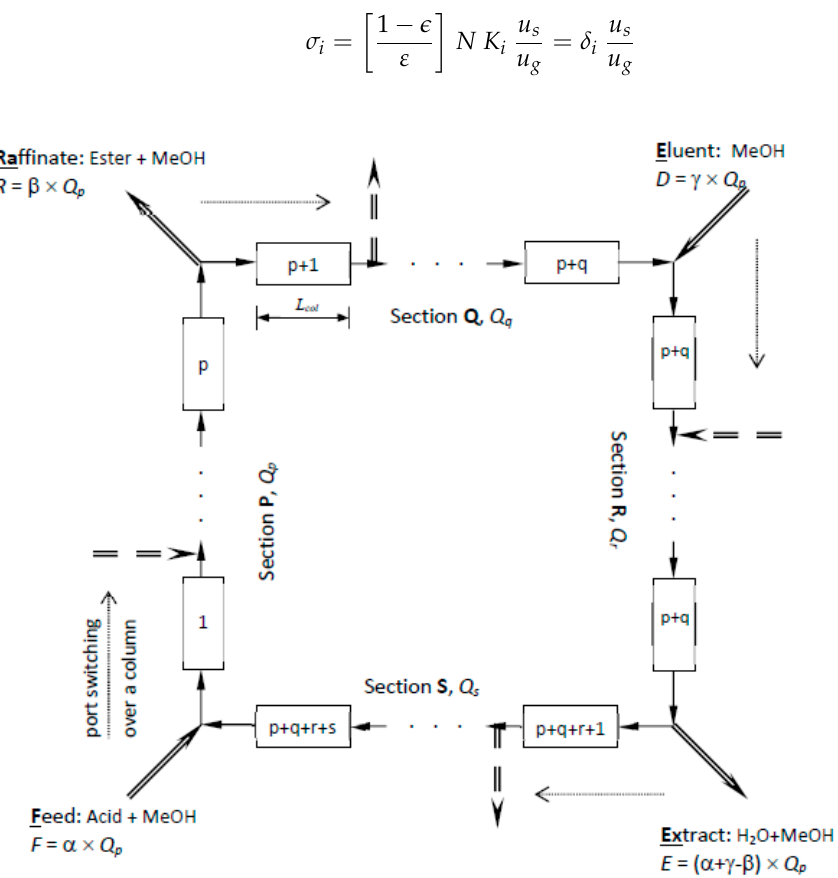
Figure 1. Schematic flow diagram of the SMBR. The inlets and outlets divide the entire system into four section, P, Q, R and S with respectively p, q, r and s number of columns. The flow retes in each section is given by Qq = (1 − β ) Qq , Qr = (1 − β + γ ) Qp , Qs = (1 − α ) Qp , where α , β and γ are given by F / Qp , Ra / Qp , E / Qp .